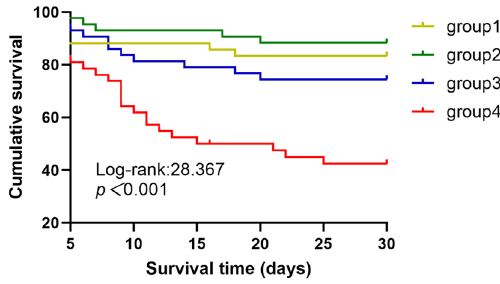
Figure 2. Cumulative risk for PLR groups and mortality in moderate and sever TBI patients. PLR for groups: group1: (< 128.0), group 2 (128.0–207.6), group 3 (207.6–330.7), group 4 (> 330.7).